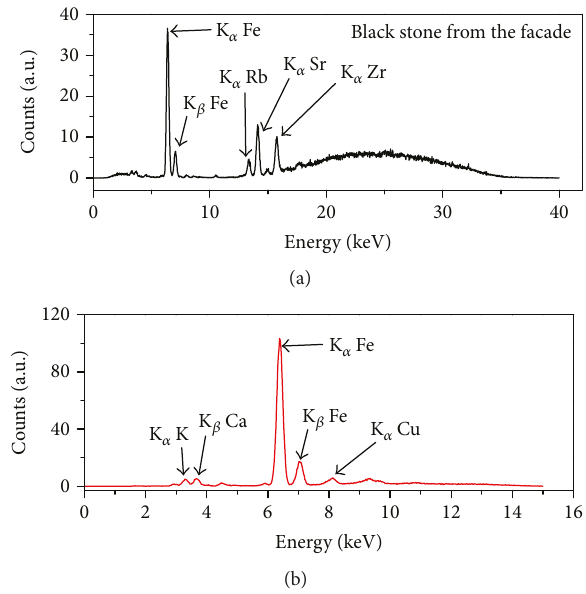
Figure 13: XRF spectra, in the 0 – 40keV range (a) and 0 – 16 keV range (b), of a black stone from the facade of the Abbey of SS. Pietro e Paolo d ’ Agrò.